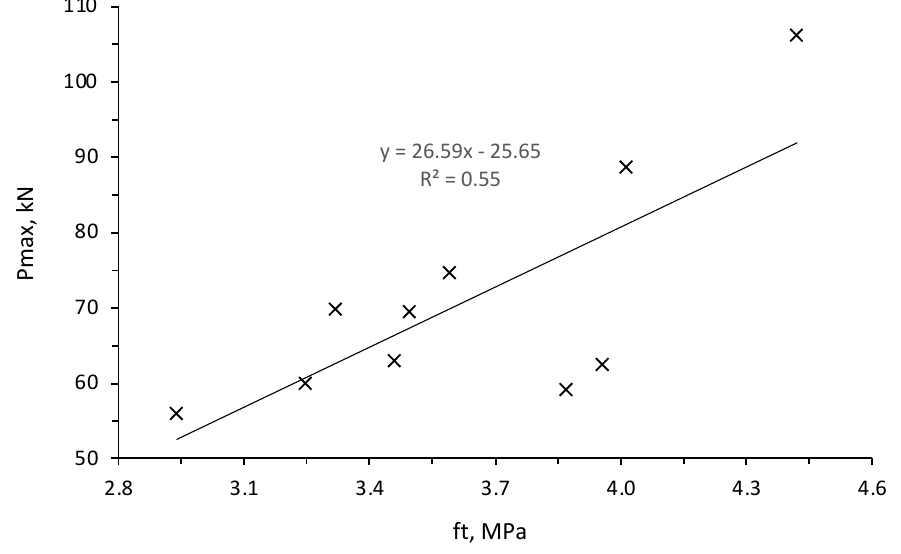
Figure 11. Relationship between P max determined on RC beams without stirrups and ft responses.